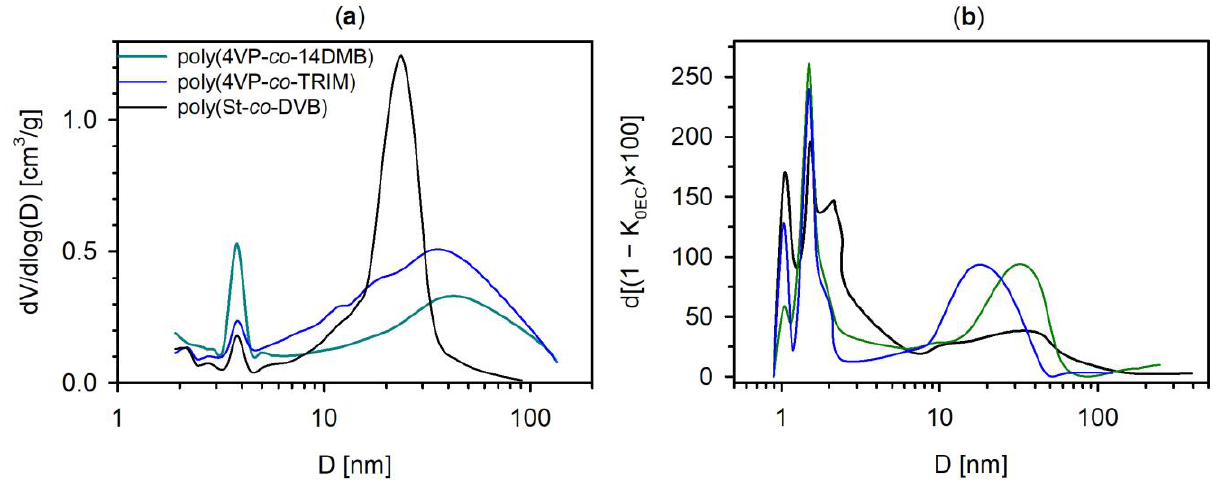
Figure 5. The PSD obtained for studied microspheres from: ( a ) the BJH method using desorption plot; ( b ) the ISEC measurements.